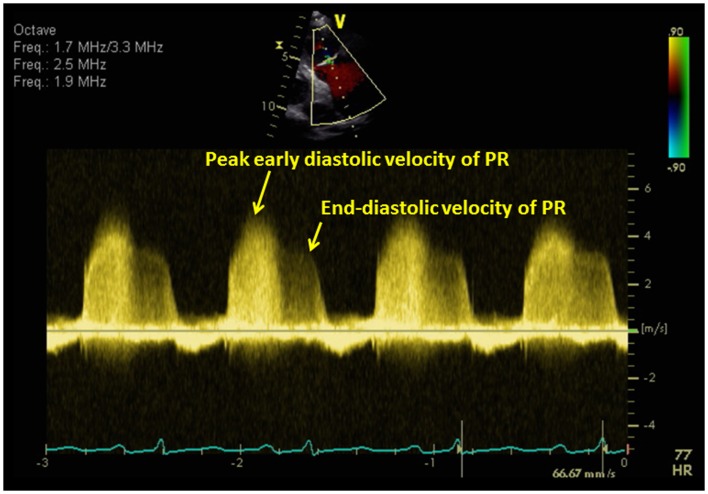
The diastolic pulmonary artery pressure (DPAP) can be estimated from the velocity of the end-diastolic pulmonary regurgitant velocity using the modified Bernoulli equation. The mean pulmonary artery pressure (mPAP) can be estimated from the following equation: mPAP = 4V(early peak pulmonary regurgitation velocity)2 + RA pressure.